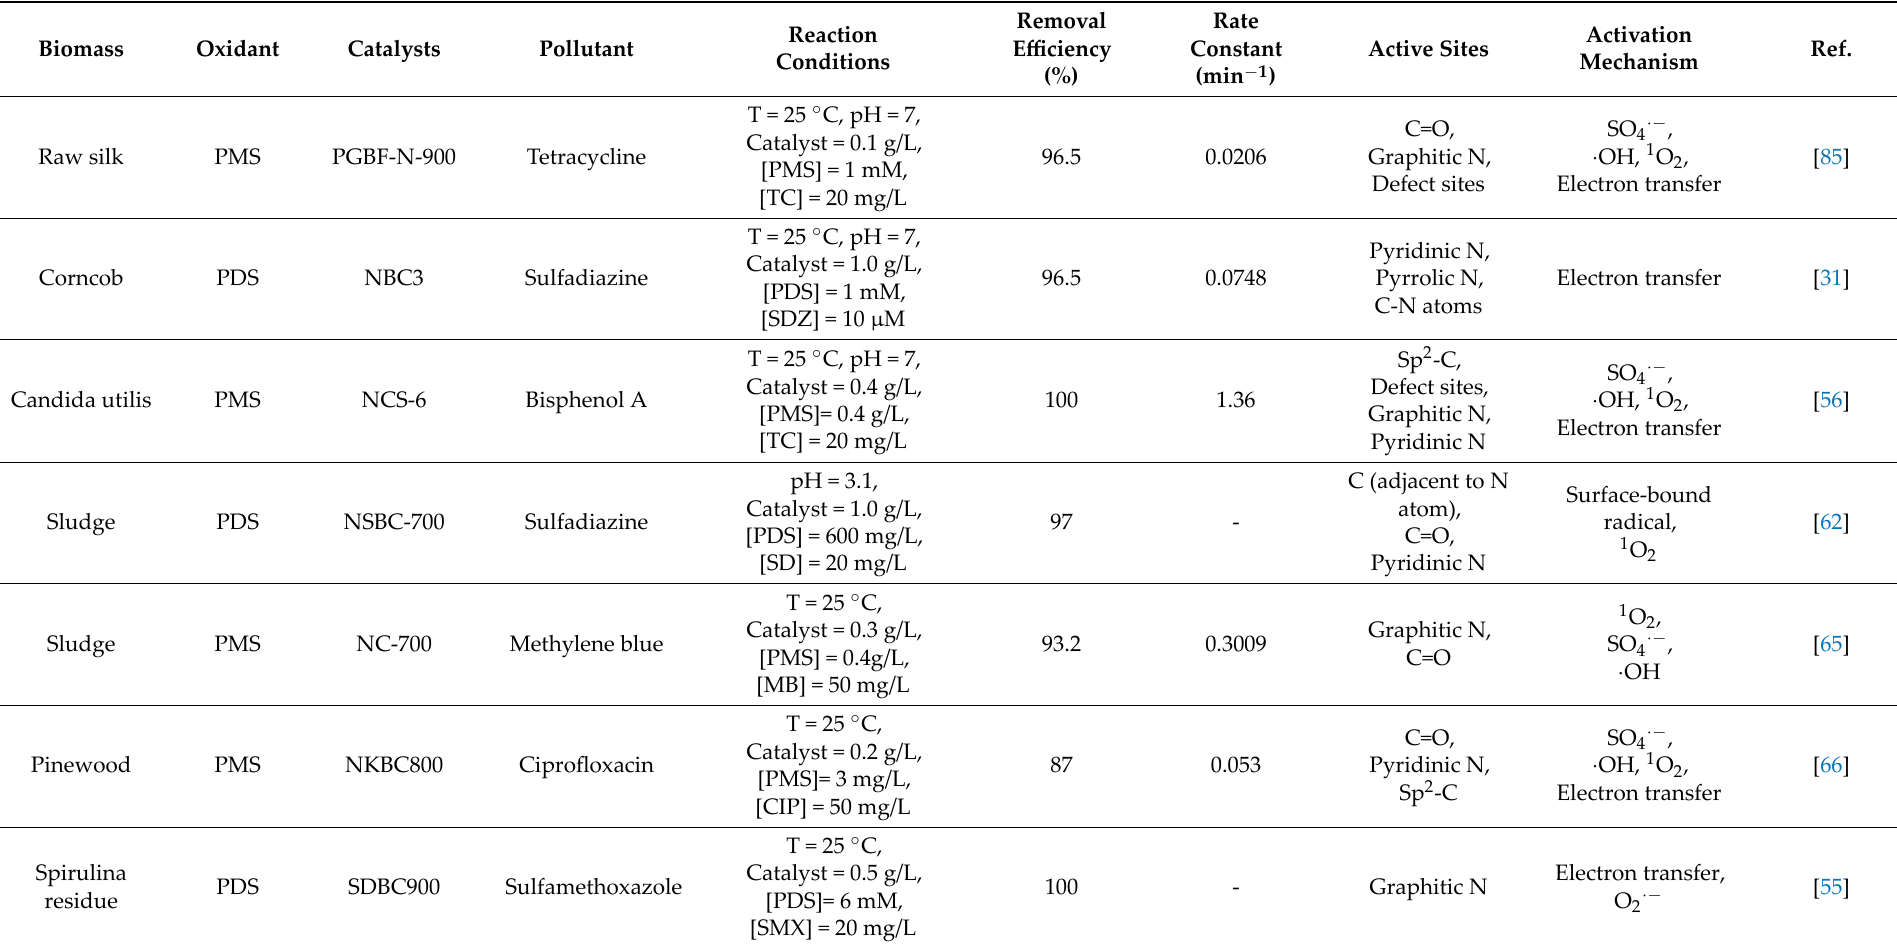
Table 2. List of N‑doped biochar as catalysts for